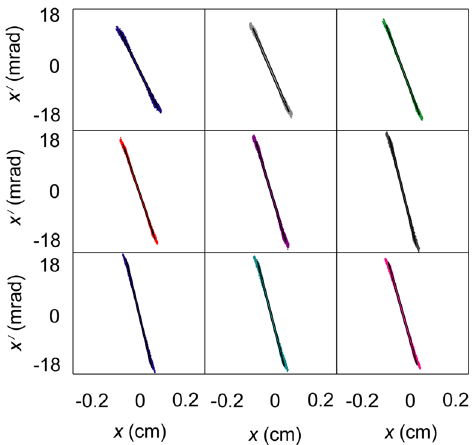
FIG. 29. Transverse phase-space of 9 consecutive slices with- out taking into account the initial thermal